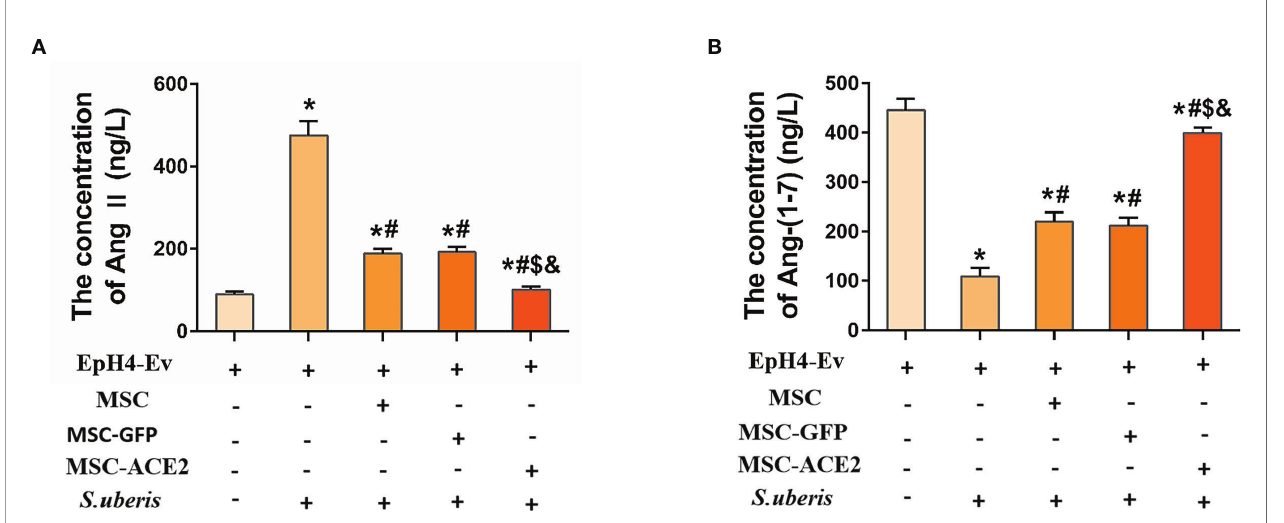
FIGURE 3 | The effects of MSC-ACE2 on EpH4-Ev cells ’ secretion of Ang II, Ang-(1 – 7). (A) Detection of Ang II concentration in cell culture supernatants by ELISA. (B) Detection of Ang-(1 – 7) concentration in cell culture supernatants by ELISA. Experiments were repeated three times and data were presented as the mean ± SEM (n = 4). * P < 0.05 vs. EpH4-Ev; # P < 0.05 vs. S. uberis ; $ P < 0.05 vs. MSC; & P < 0.05 vs.